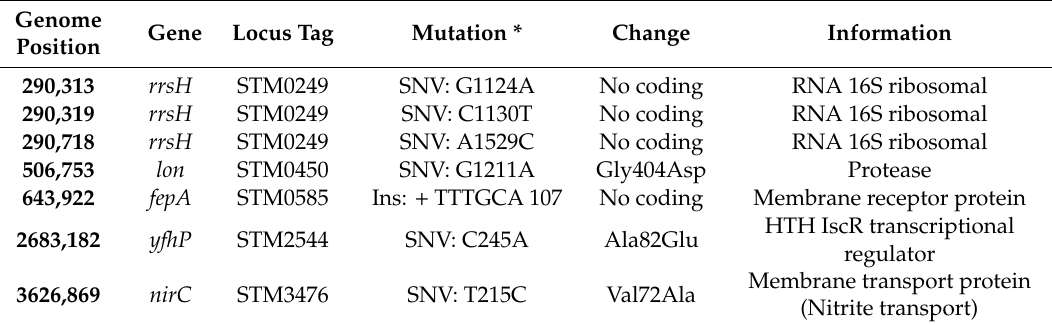
Table 4. Mutations of SeSCar (strain evolved by cyclic exposure to prolonged sublethal treatments of carvacrol) in comparison with Salmonella enterica subsp. enterica serovar Typhimurium LT2 wild type (SeWT), verified by Sanger sequencing. Single nucleotide variation (SNV), insertion (Ins) and deletion (Del).